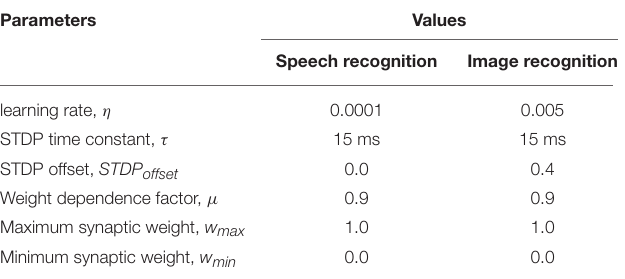
TABLE 3 | STDP model parameters for different pattern recognition tasks. TABLE 4 | Number of examples used to train the Liquid-SNN and SpiLinC for recognizing digit utterances from the TI46 speech